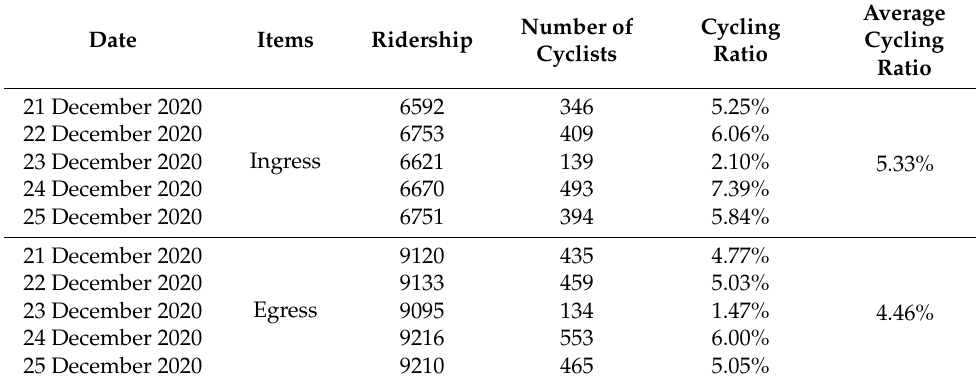
Table 5. Urban rail and bicycle-sharing ridership.